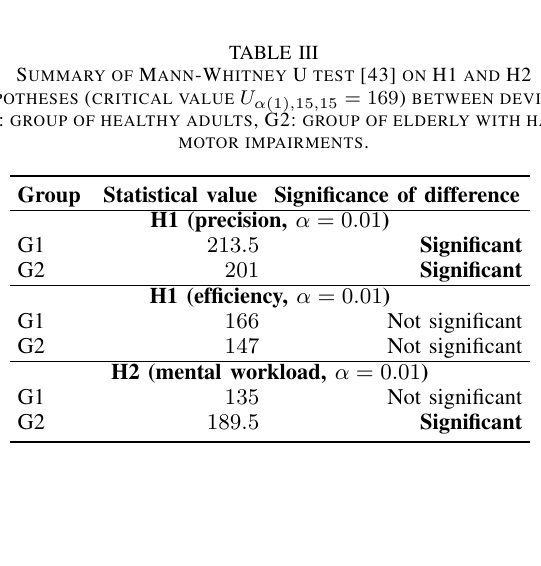
TABLE III S UMMARY OF M ANN -W HITNEY U TEST [43] ON H1 AND